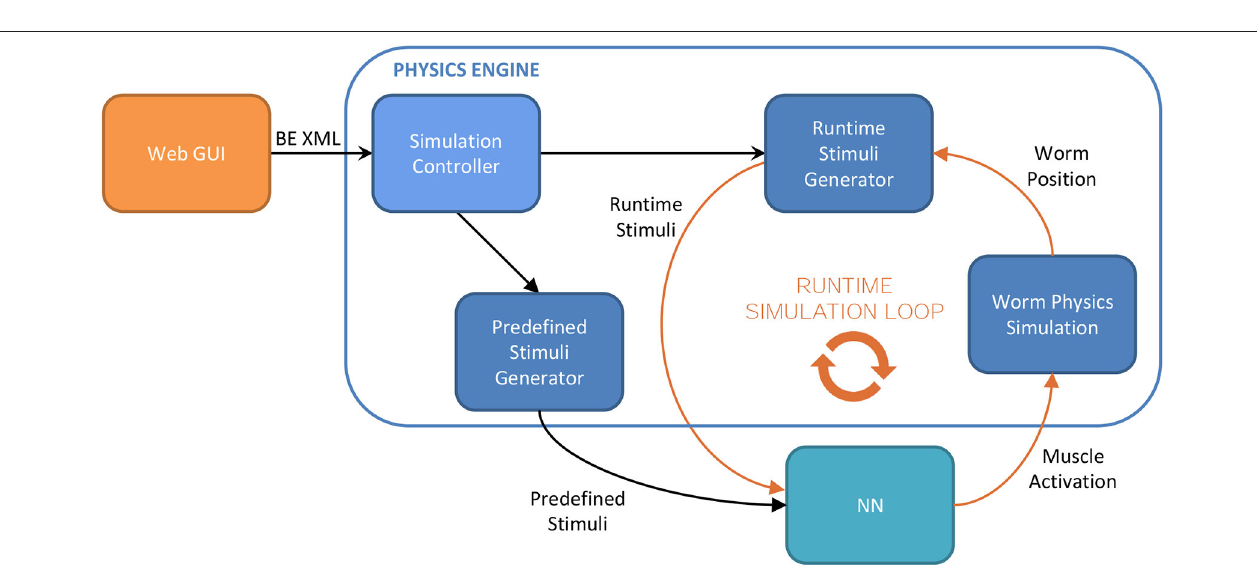
FIGURE 6 | Central points located along the whole body of the worm are used to compute the curvature of the body at that point.